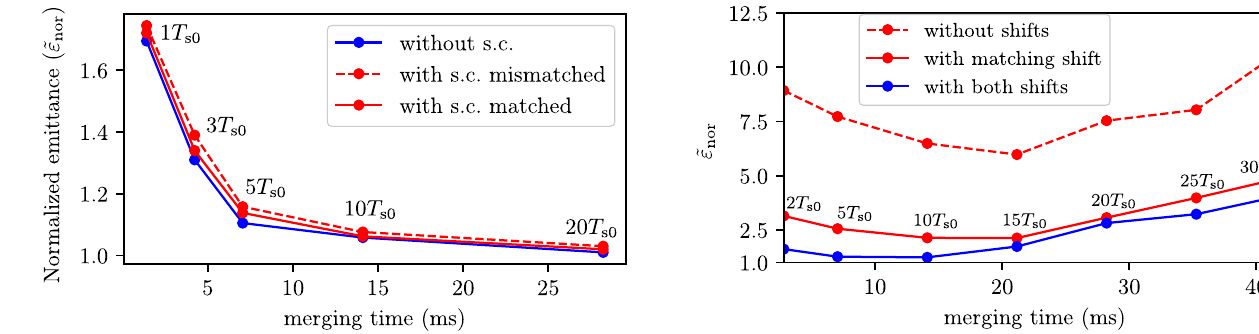
FIG. 10. Comparison of the final normalized emittance with different merging times, 20 T three cases: in the absence of space charge (solid blue), in the presence of space charge but without space-charge matching (red dashed); in the presence of space charge and with space-charge matching (red solid).